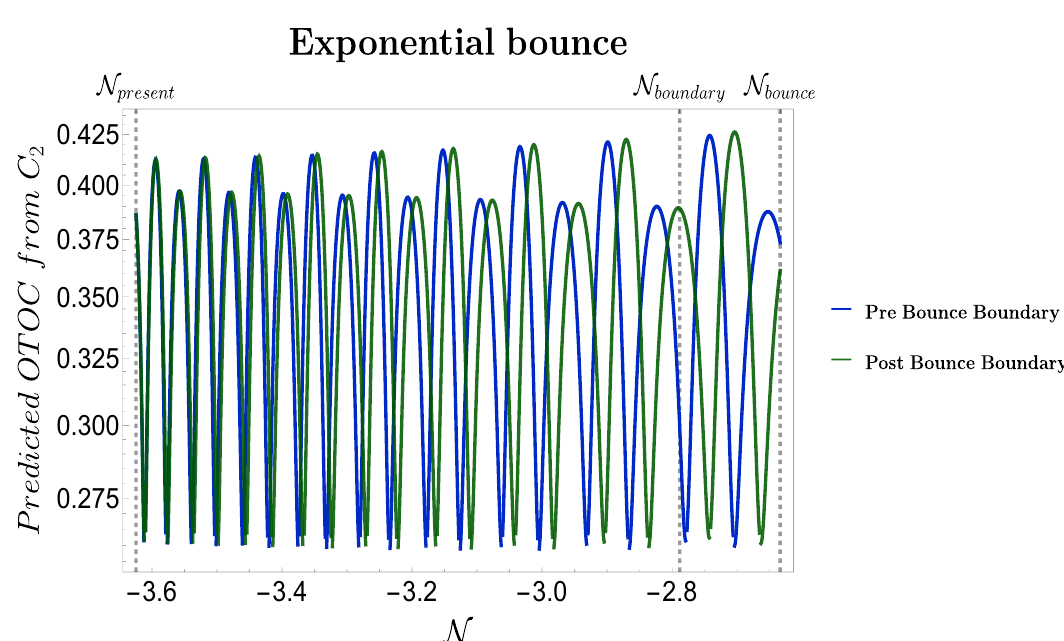
Figure 42: Predicted OTOC from geodesically weighted complexity outside bouncing region with respect to number of